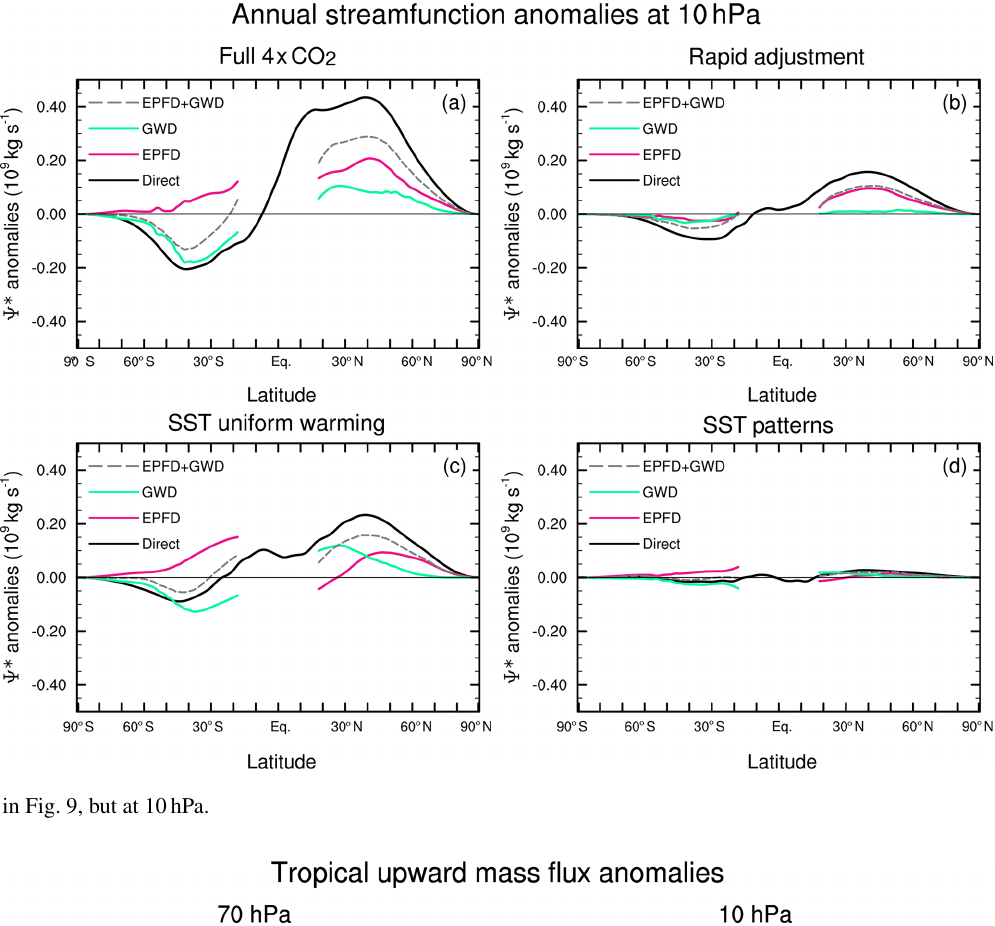
Figure 10. As in Fig. 9, but at 10hPa.